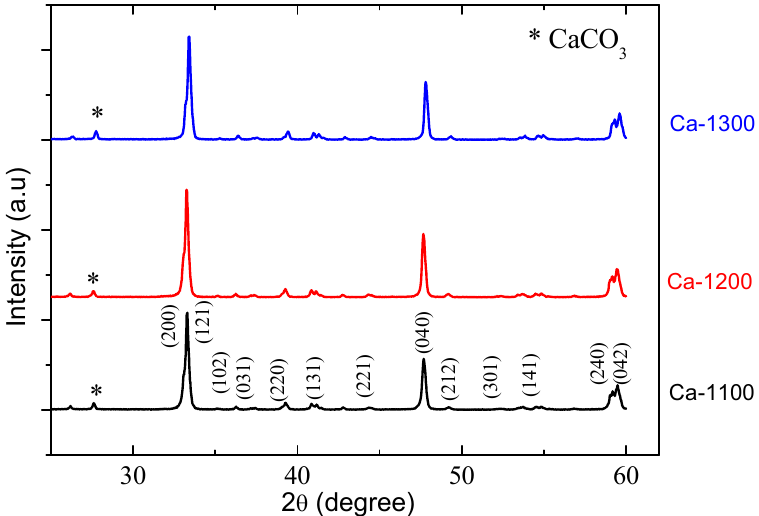
Figure 1. XRD patterns of Ca-1100, Ca-1200, and Ca-1300 ceramic samples. The asterisk refers to CaCO 3